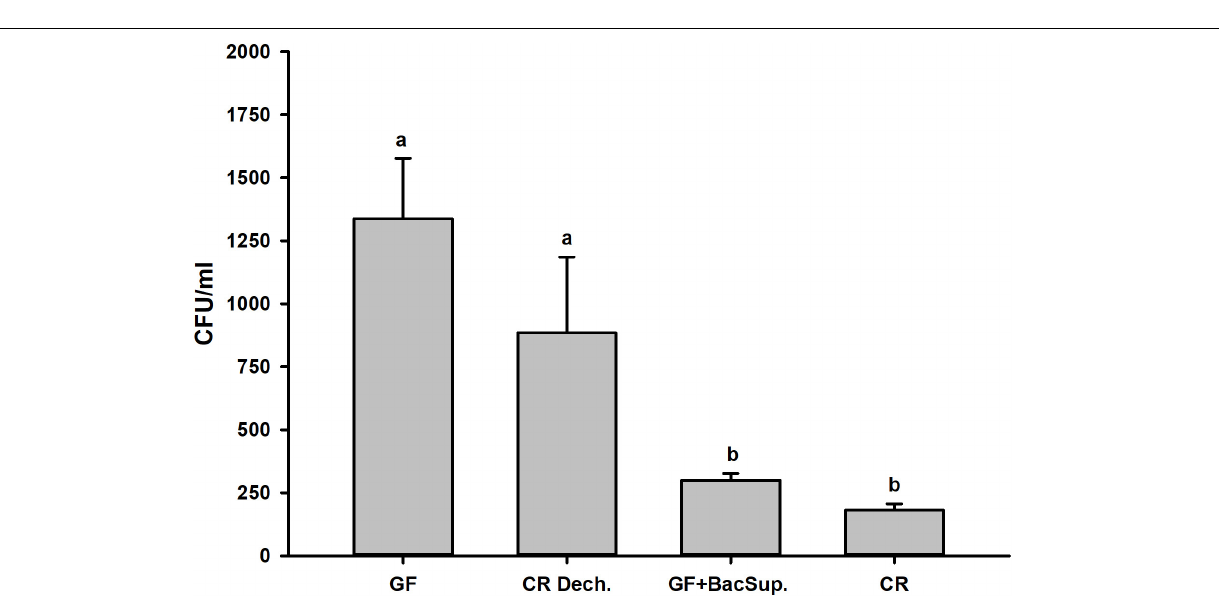
FIGURE 1 | The Phenoloxidase (PO) activity of symbiotic (CR Dech., GF BacSup., and CR) and aposymbiotic (GF) RPW larvae. Uppercase letters indicate the statistical differences of PO activity across different PBS injection groups, whereas the lowercase letters represent the significance of PO activity across different bacterial infection groups using post hoc multiple comparisons Tukey’s HSD (Honest Significant Difference, P < 0.05). Pairwise comparison for each cohort was performed between infected and control counterparts with independent t- test to reveal the effect of bacteria challenge on PO activity. Error bars represent the standard deviation of five independent replicates (ns, P > 0.05).